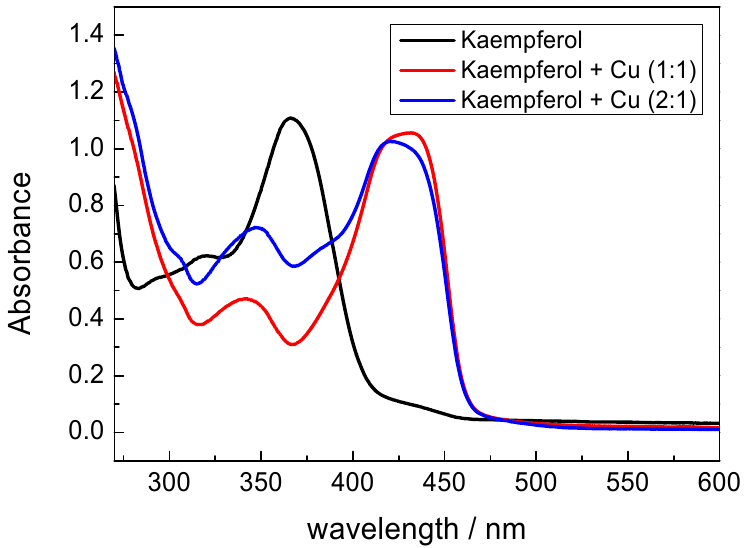
Figure 4. UV-vis spectra of kaempferol and its Cu(II) complexes (1:1 and 1:2) in methanol. [Cu(II)] = 0.1 mM. The spectra were recorded 5 min after mixing of the copper solution with kaempferol. In summary, the UV ‐ vis spectra of flavonoids are characterized by π → π * transi ‐ tions at about 240–290 nm, which are associated with the rings A and C [24]. These tran ‐ sitions are usually denoted as bands II and belong to benzoyl system of the skeleton.